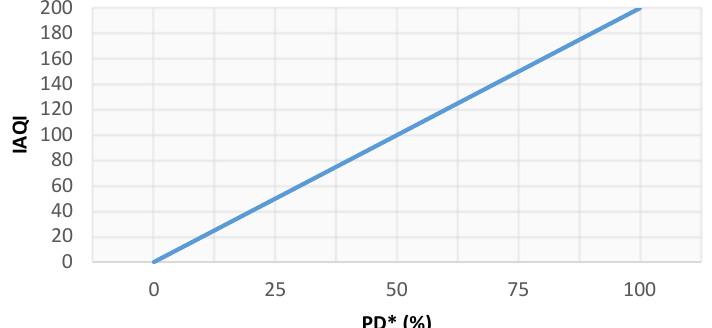
Table 8. Physical parameters (Footnote 1 in Table 5) and IEQ results calculated from Equation (9) Figure 8. Percentage of persons dissatisfied, % PD *, in relation to IAQI with ∑ IAQ; assuming realistic uncertainty of parameter measurements for the case study building Figure 7. percentage of persons dissatisfied, % PD *, in relation to IAQI values. (47th floor; open space) a few days after completion of the finishing works.